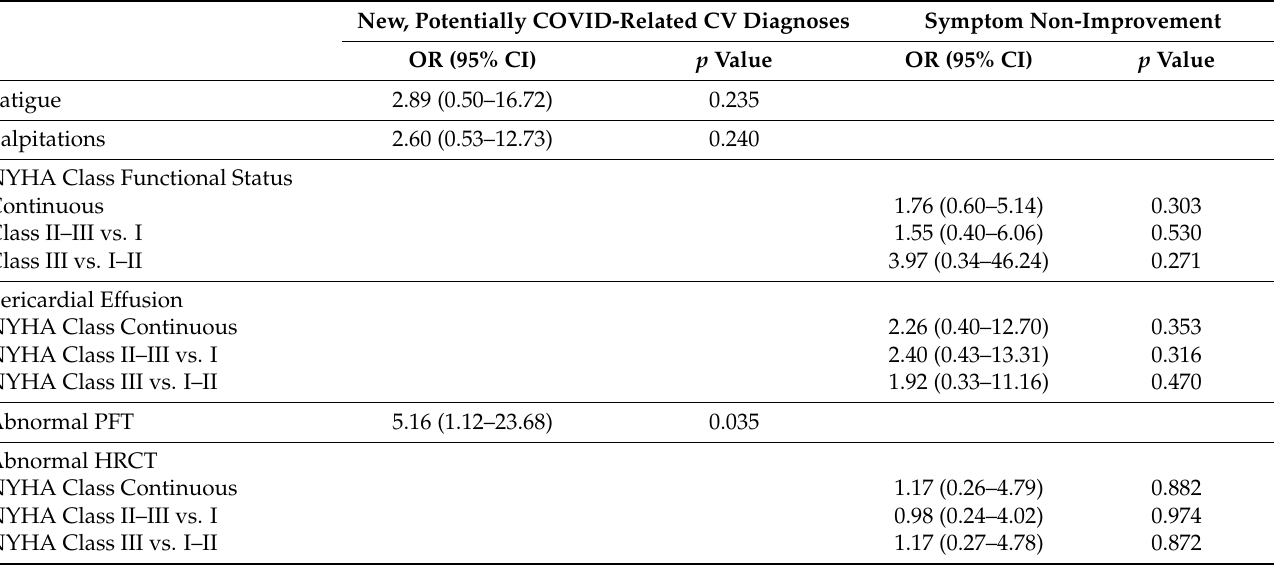
Table 6. Multivariate binary logistic regression model for the outcomes of new, potentially COVID- related cardiovascular diagnoses and symptom